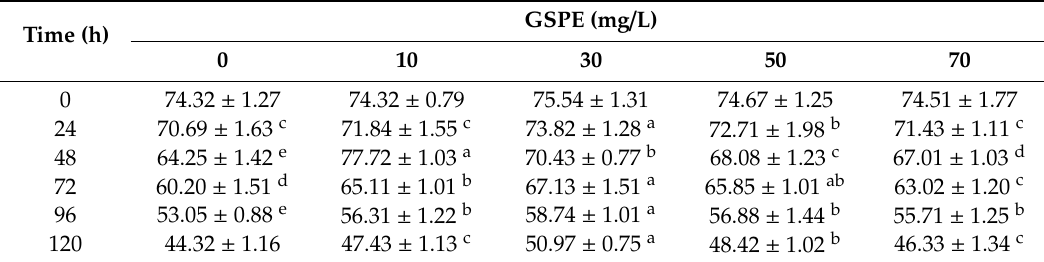
Table 2. E ff ect of grape seed procyanidin extracts (GSPE) on the plasma membrane integrity of goat sperm of preserved at 4 ◦ C (%).